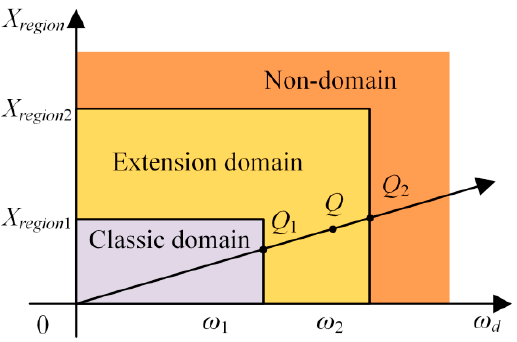
Figure 6. 1-D extension set of car-following distance error.